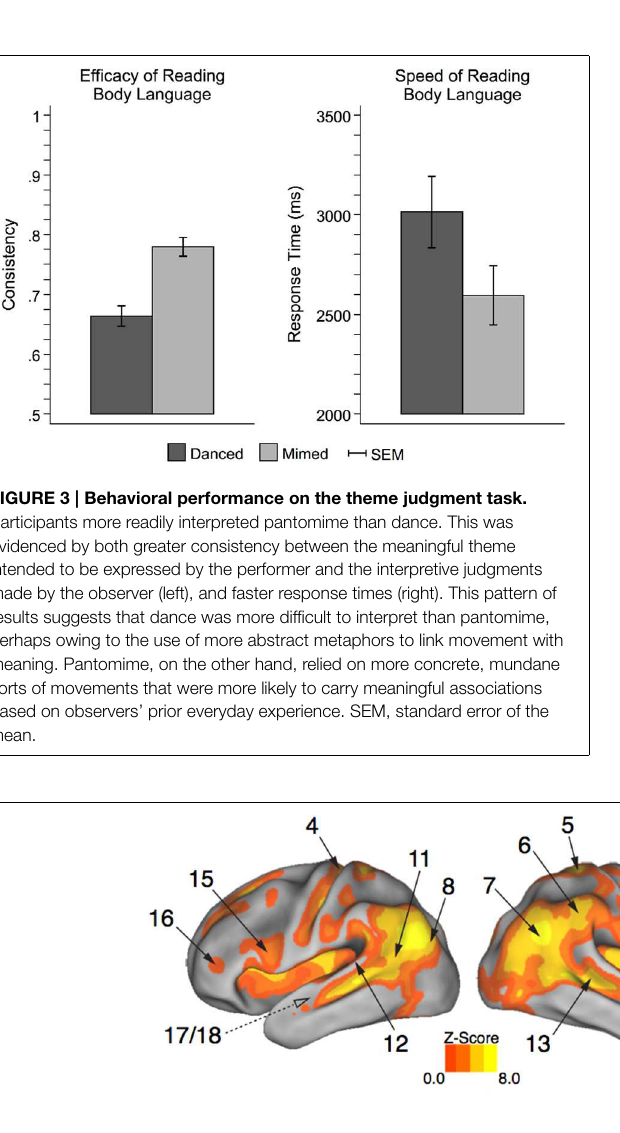
FIGURE 4 | Expressive performances engage the action observation network. Viewing expressive whole-body movement sequences engaged a distributed cortical action observation network ( p < 0 . 05 , FWE corrected). Large areas of parietal, temporal, frontal, and insular cortex included somatosensory, motor, and premotor regions that have been considered previously to comprise a human